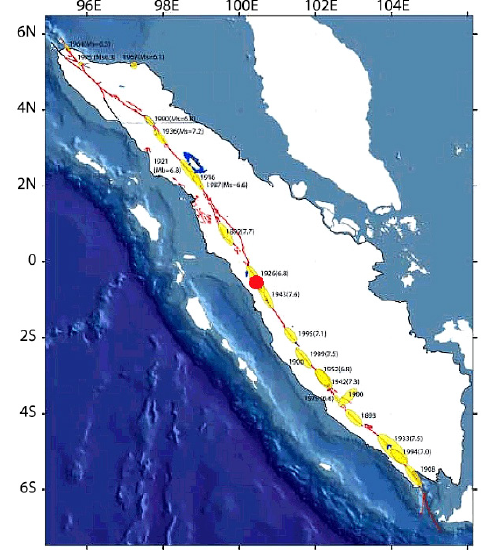
Figure 1. Semangko fault and Sianok-Sumani segment (Geological, 2017). The red circle is the research